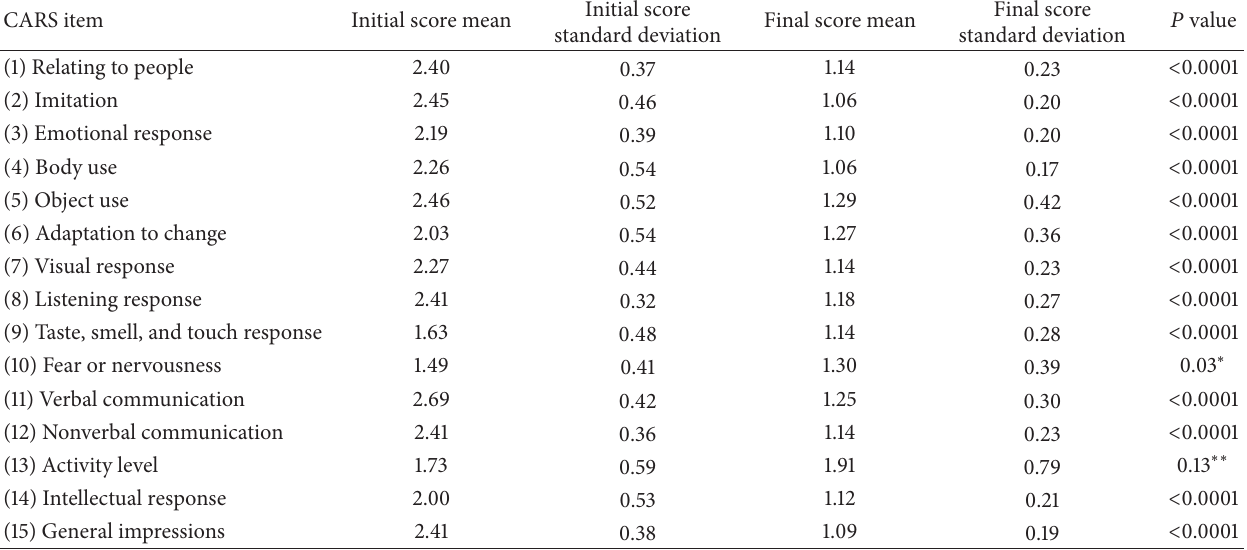
Table 2: Changes in CARS items.